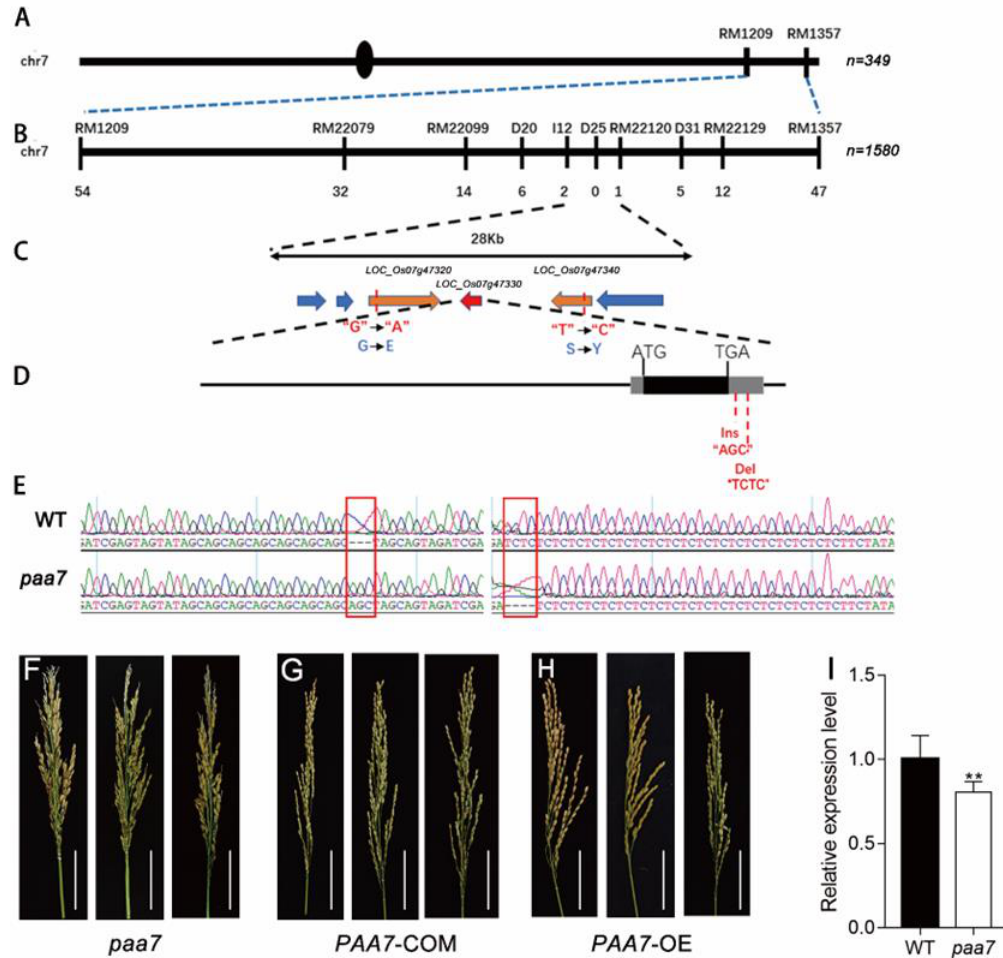
Figure 4. Mutation of 3′ -UTR of PAA7 caused panicle apical abortion. ( A ) The PAA7 locus was mapped to the long arm of chromosome 7 between the markers RM1209 and RM1357. ( B ) Mapping of the PAA7 locus between markers I12 and RM22120. ‘n’ represents homozygous recessive individuals derived from an F 2 population from the cross paa7 × II -32B, paa7 × 9311. The number of recombinants is indicated below the map. ( C ) The PAA7 locus was narrowed down to a 28 kb region, including six putative protein-encoding genes. ( D ) There are 3bp (AGC) insertion and 4bp (CTCT) deletion in the 3′UTR in FZP of paa7 mutant. ( E ) Sequencing results of WT and paa7 gDNA, red box indicated the mutant site. (F-H) Panicles of paa7 mutant plants ( F ), complementary transgenic plants ( G ) and overexpressed transgenic plants ( H ), Bars = 5 cm. ( I ) Expression of FZP in WT and paa7 mutant, data are means ± SD ( n =3), asterisks indicate significant difference by Student’s t -test (** p < 0.01). There were six predicted coding genes located in this interval region